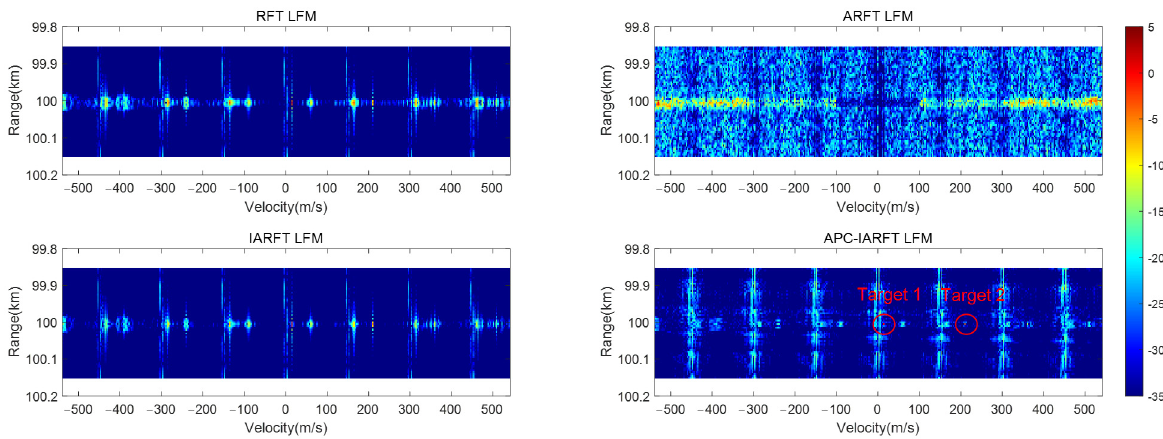
Figure 15. Plan output of four methods in Scenario 4.